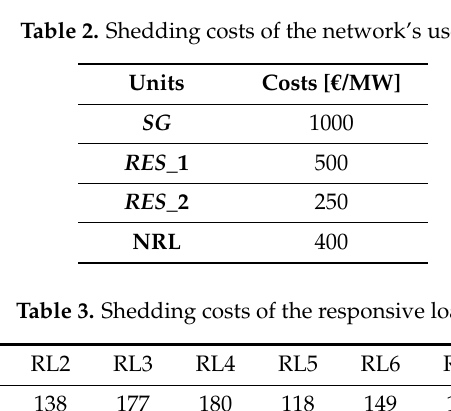
Figure 10. Frequency response of the test network.